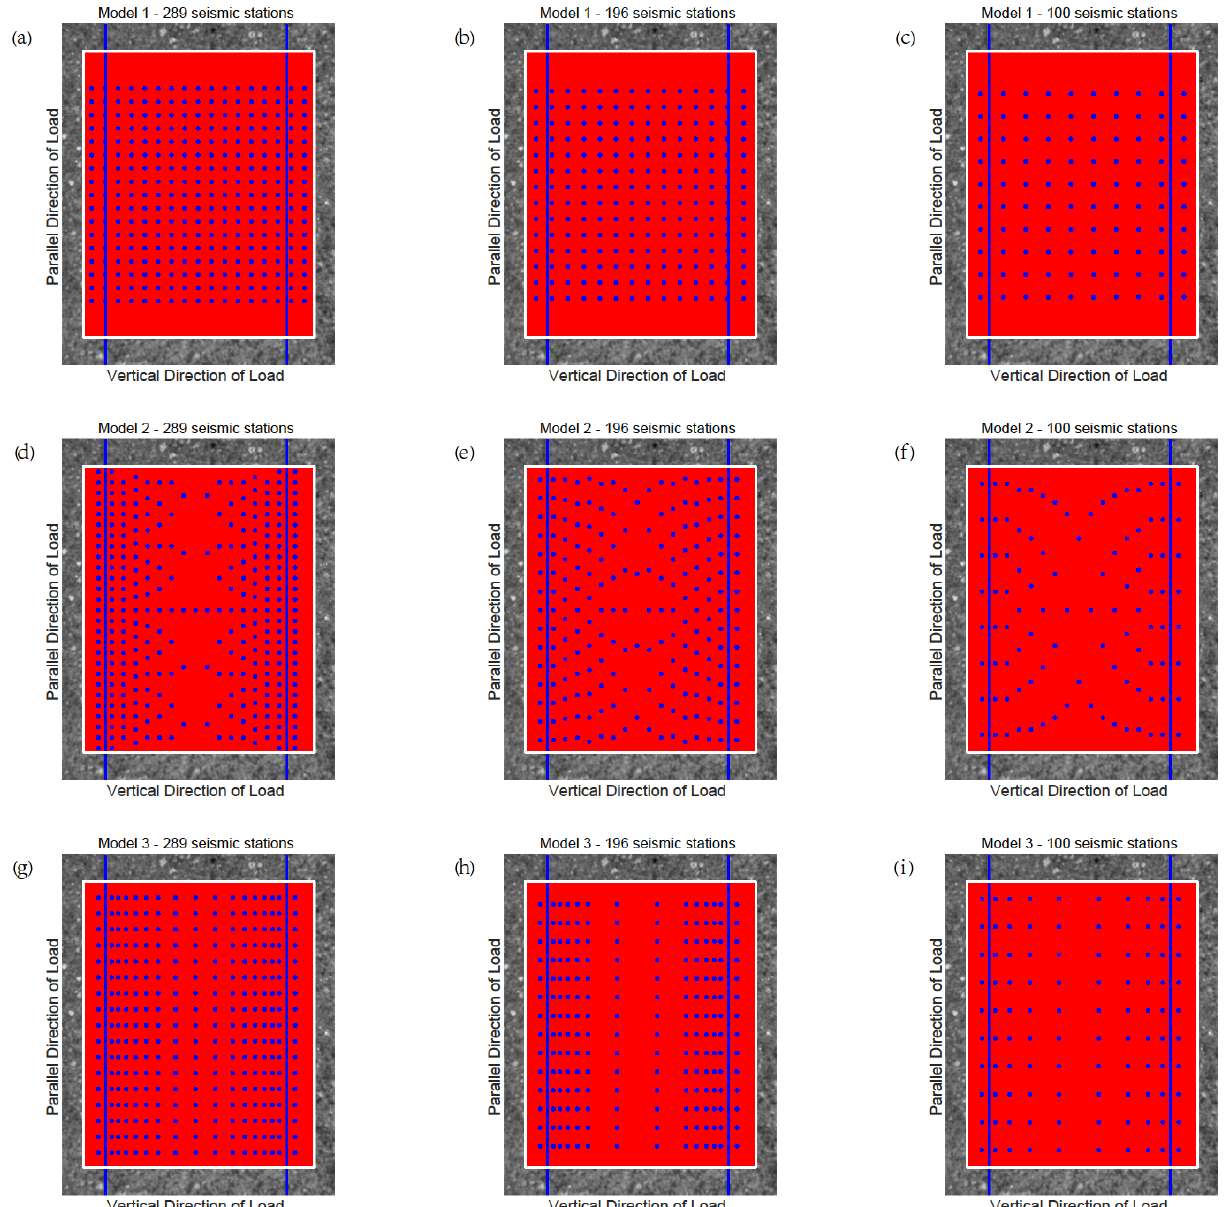
Figure C1. Three kinds of seismic monitoring models with different numbers of seismic monitoring stations for sample 1. The blue lines indicate the prefabricated cracks. Each figure shows the observational area of sample 1. The area enclosed by the white rectangle is the calculation area. The red points in the calculation area represent the sampling points. The blue points indicate the locations of seismic stations in different models. The horizontal axis is perpendicular to the direction of load. The vertical axis is parallel to the direction of loading. Subfigures represent various models with different numbers of seismic monitoring